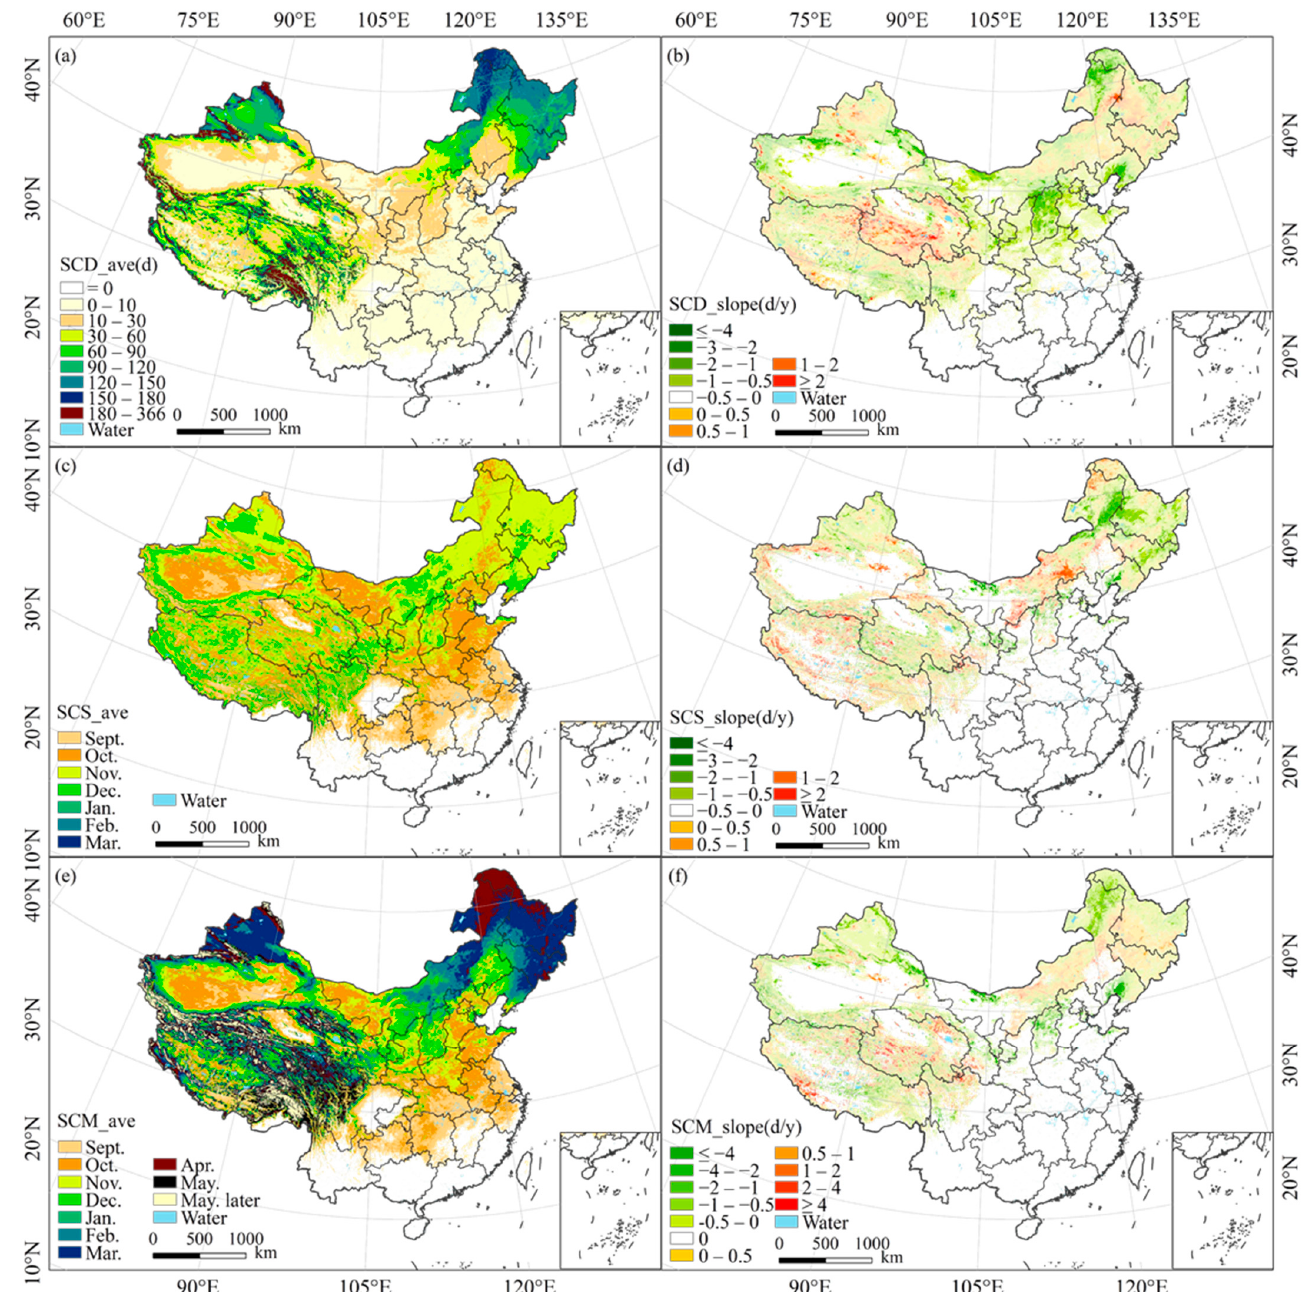
Figure 2. Average of ( a ) days (SCD); ( c ) start (SCS); and ( e ) melt (SCM) of snow cover for 2000–2020. Trend of ( b ) days (SCD); ( d ) start (SCS); and ( f ) melt (SCM) of snow cover for 2000–2020; opaque pixels indicate trends significant at the 95% level.